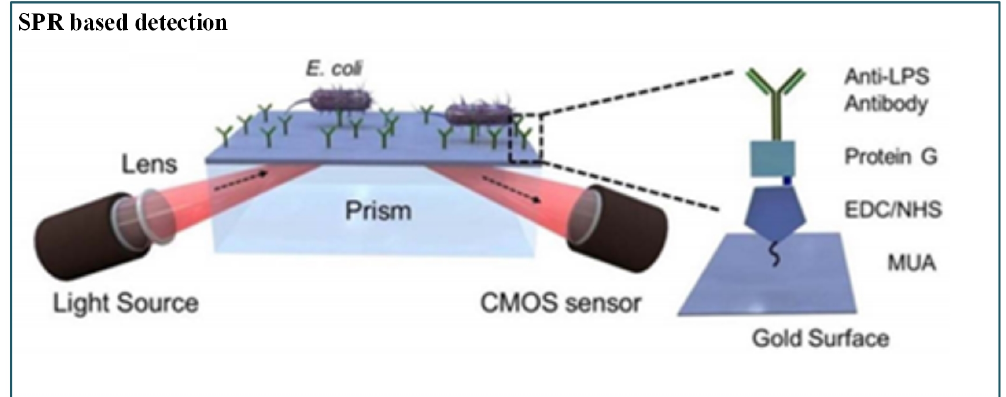
Figure 11. Schematic of SPR-based pathogenic detection